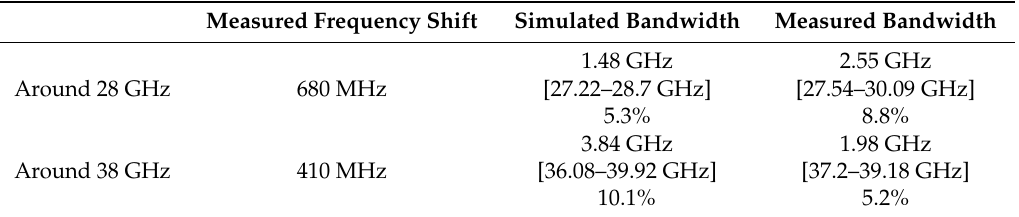
Table 3. Dual-Band S 11 Parameter Characteristics.